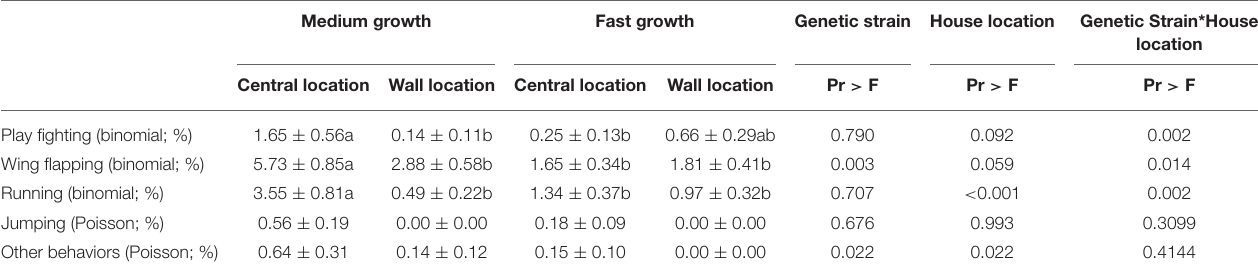
TABLE 2 | Effect (mean ± se) of broiler genetic strain (medium vs. fast growth broilers), of the house location where welfare assessments were carried out (central vs. wall locations), and of their interaction on the occurrence of positive behaviors detected during welfare